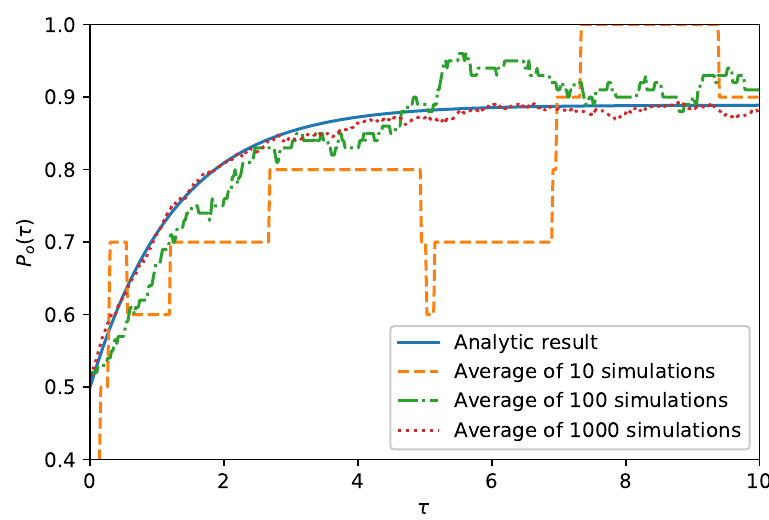
Figure 12 . Probability of having a static quarkonium in a color state as a function of (cid:28) = 2 C F (cid:11) s Tt= 10 assuming that the initial probability is 1 = 2 and the temperature T = 250 MeV . We compare the analytic results with the average of di(cid:11)erent number of